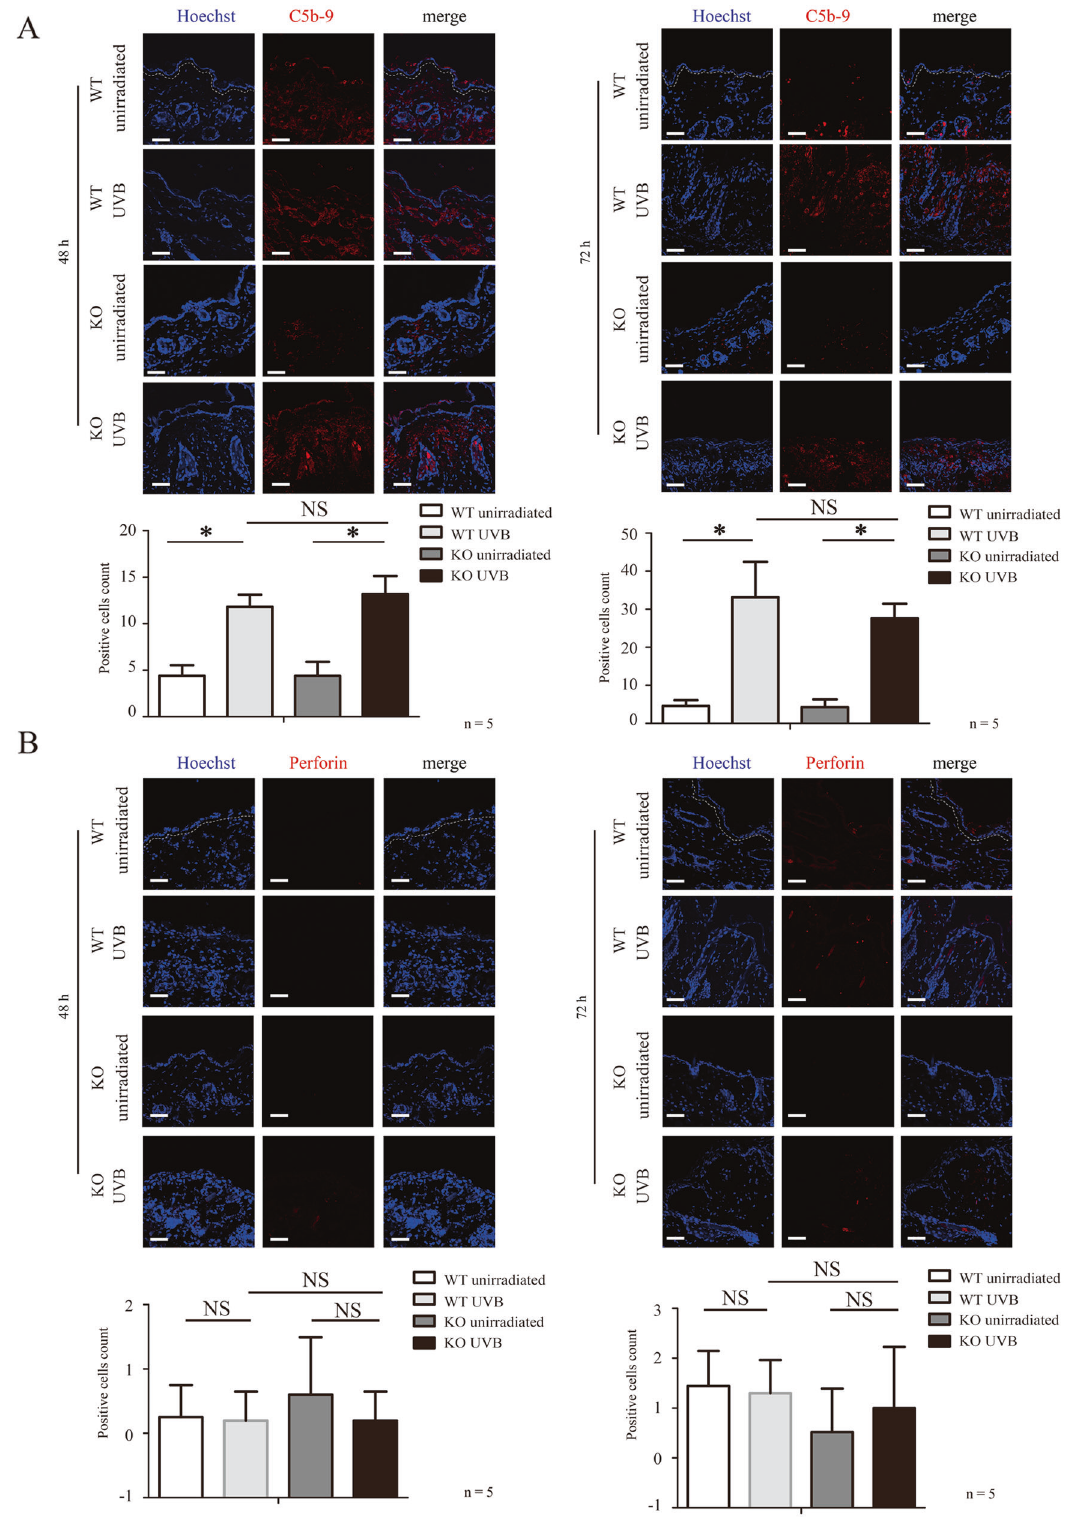
Fig. 3 Membrane attack complex C5b-9 and perforin do not contribute to the increase of keratinocyte death of UVB-challenged Gsdme − / − mice. A , B Membrane attack complex C5b-9 ( A ) and perforin ( B ) were detected in skin tissue at 48 and 72 h after UVB exposure by immuno fl uorescence assay ( n = 5). The nucleus was stained by Hoechst. Scale bar represents 100 μ m. C NK1.1 + NK cells were detected in skin tissue at 48 and 72 h after UVB exposure by immunohistochemistry assay ( n = 5). The scale bar represents 100 μ m. D The neutrophil extracellular traps indicator, Citrullinated Histone H3 was detected in skin tissue at 48 and 72 h after UVB exposure by immuno fl uorescence assay ( n = 5). The nucleus was stained by Hoechst. The scale bar represents 100 μ m. NS nonsense.